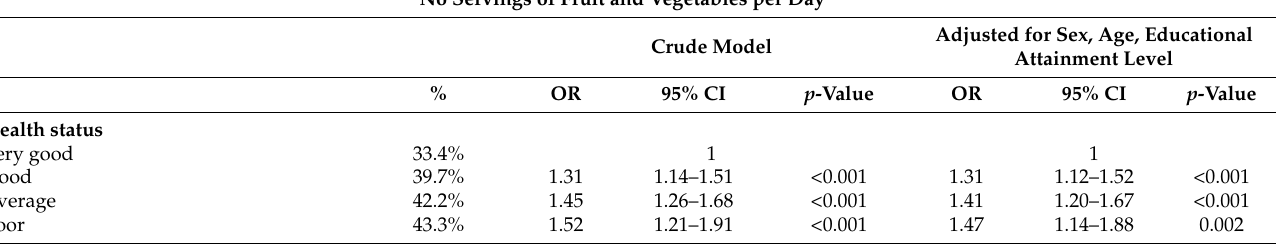
Table 4. Association between no servings of fruit and vegetables per day and health status, BMI categories, and subjective body weight estimation of